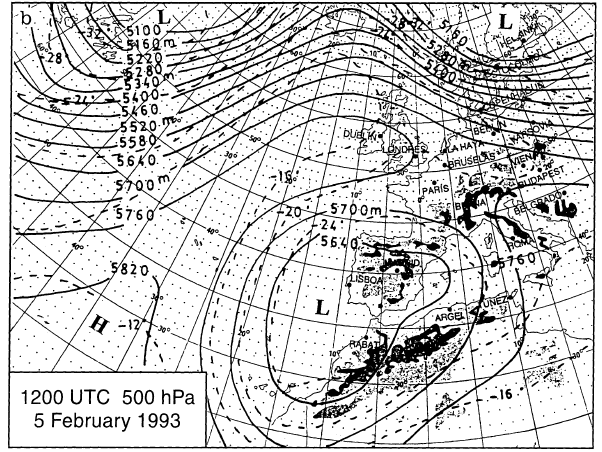
Fig. 11a,b. Same as Fig. 2 except for 5 February 1993 at 1200 UTC